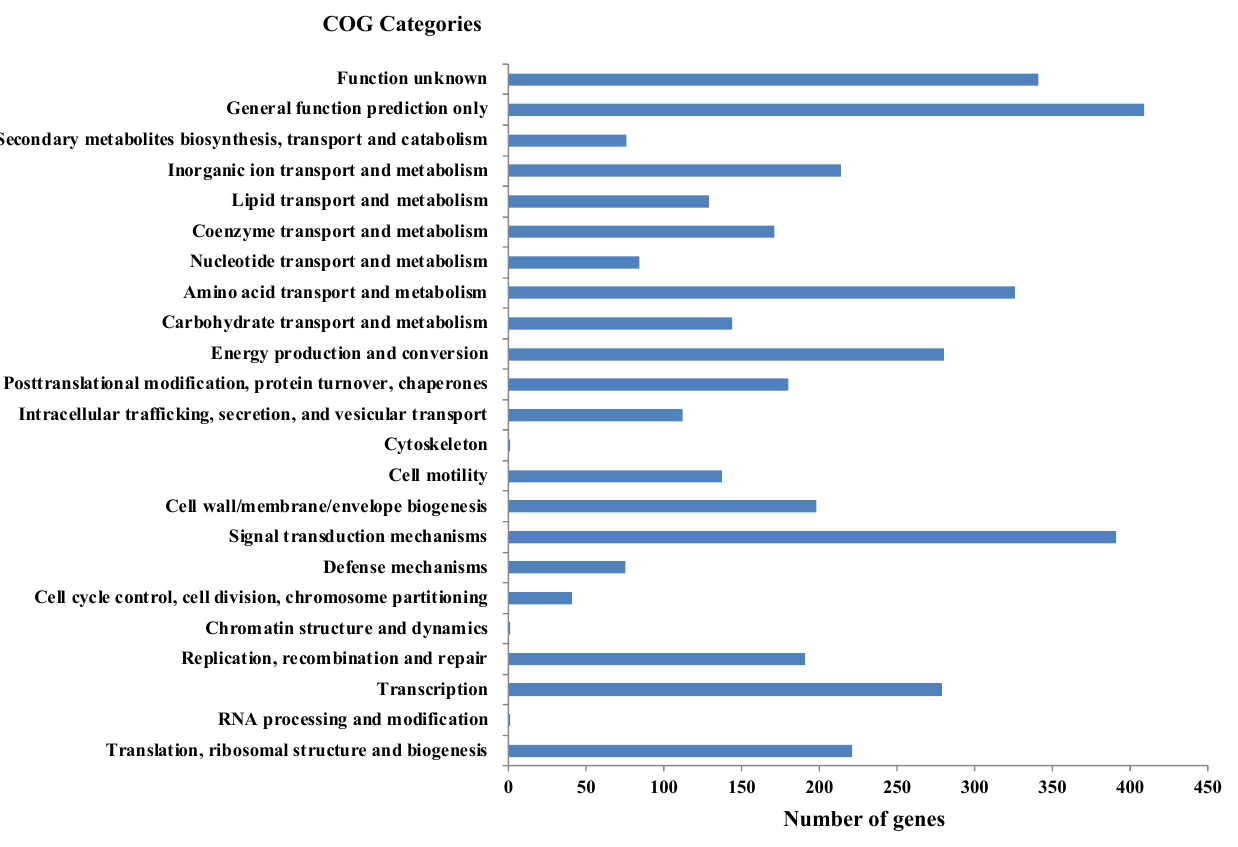
Figure 6. Distribution of COG functional categories of Shewanella sp. N2AIL genome. Table 1. Secondary metabolite gene cluster of Shewanella sp. N2AIL